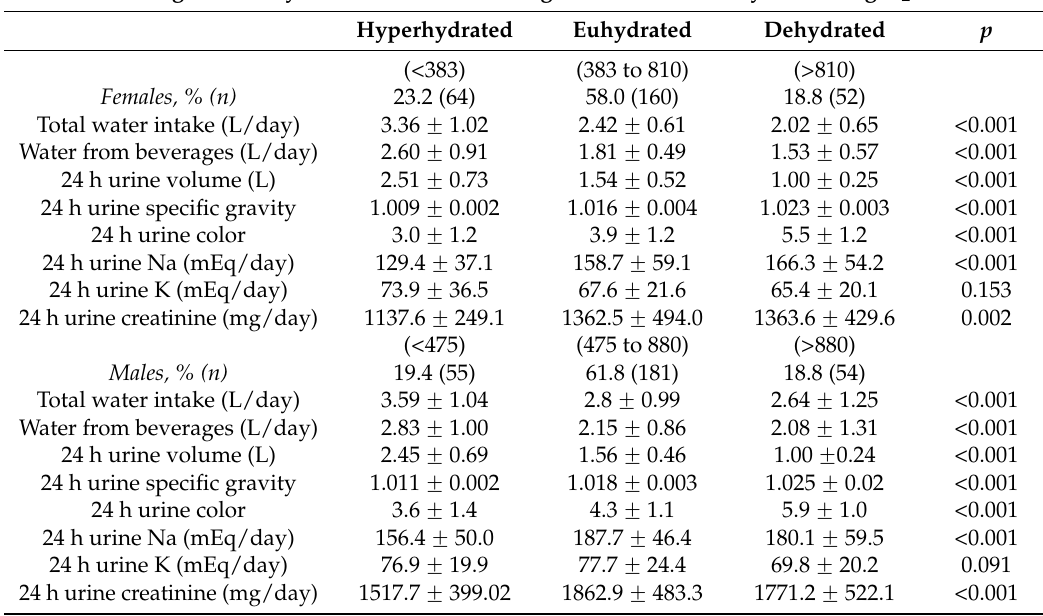
Table 4. Water intake and 24 h urine indices of females and males, according to the categories of hydration status based to urine